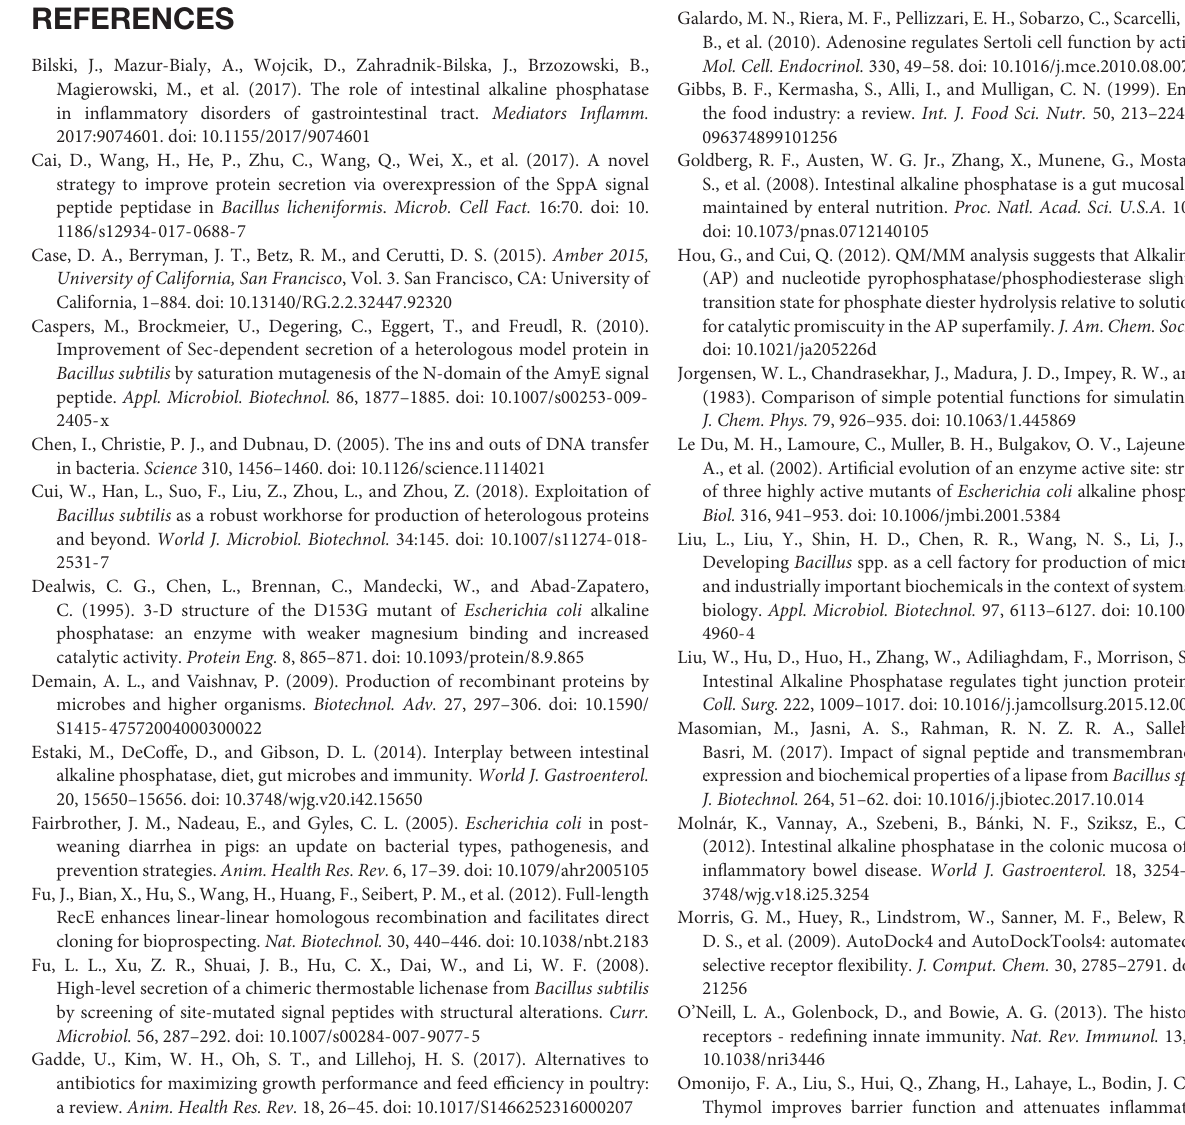
Supplementary Figure 1 | The three initial structures ligand interaction diagram. Panel (A) is the binding pocket of AKP-ligand complex; panel (B) is the binding pocket of DelSig phoA -ligand complex; panel (C) is the binding pocket of DelSigD 153 G-D 330 N-ligand complex. The yellow dash lines represent the hydrogen bonds, magenta dash lines represent salt bridges, cyan dash lines represent the Pi- Pi stacking interactions, green dash lines represent Pi-cation interactions. Supplementary Figure 2 | Plasmid stability of D 153 G-D 330 N in B. subtilis . The culture was transferred into the new LB medium, and the number of cells was counted on plates with and without kanamycin (resistance colony) in each generation after culturing for 12 h. The ratio of kanamycin resistant clones to total cells was calculated. Error bars, SD; n =